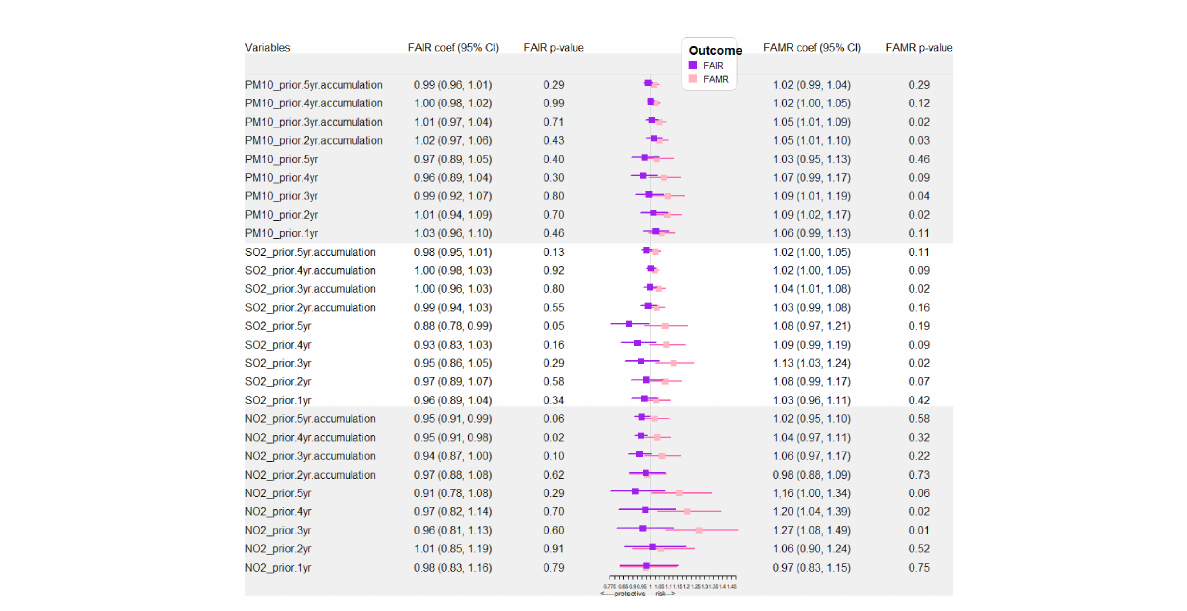
FIGURE 4 Air pollutant exposure-related RRs of FAIR and FAMR with a 5-year moving window. YAV, yearly average values ( m g/m 3 ). RR, risk ratio (with 95% CI); FAIR, female age-adjusted incidence rate; FAMR, female age-adjusted mortality